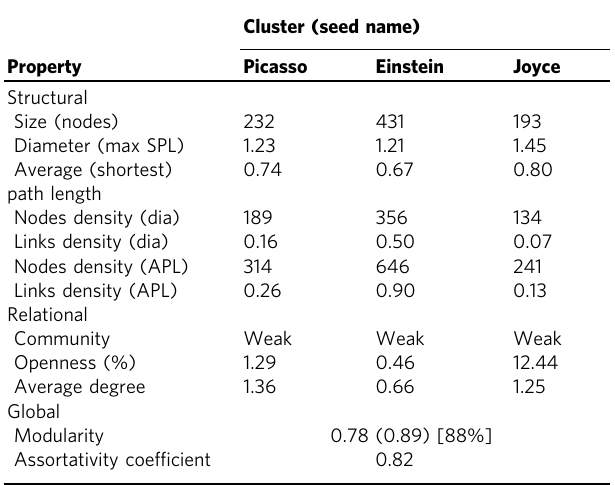
Table 1 Structural, relational and global properties of the